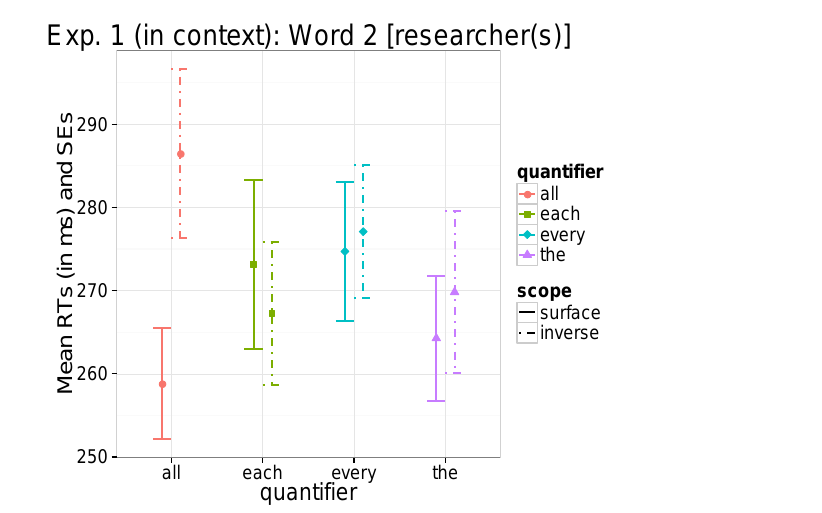
Figure 4 Mean RTs and SEs for Word 2 in Experiment 1 (in